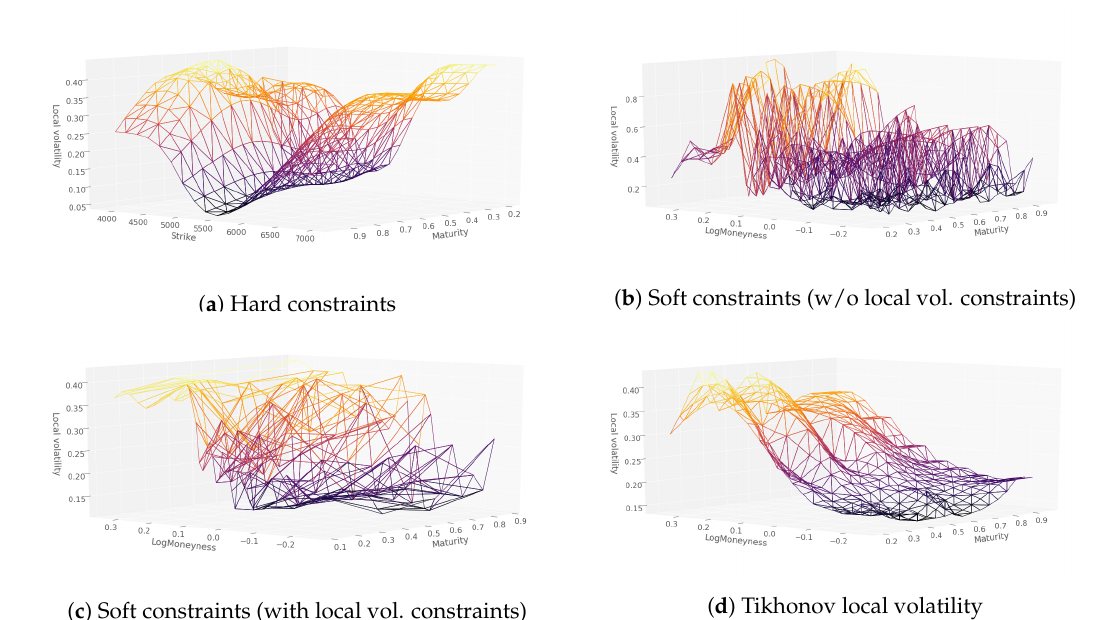
Figure 10. Local volatility for 7 August